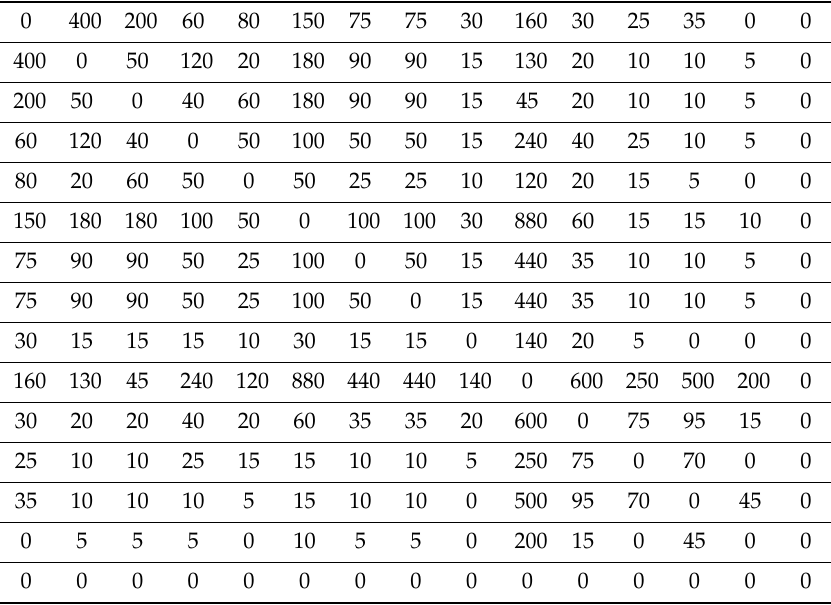
Table 1. Travel demands for Mandl’s network